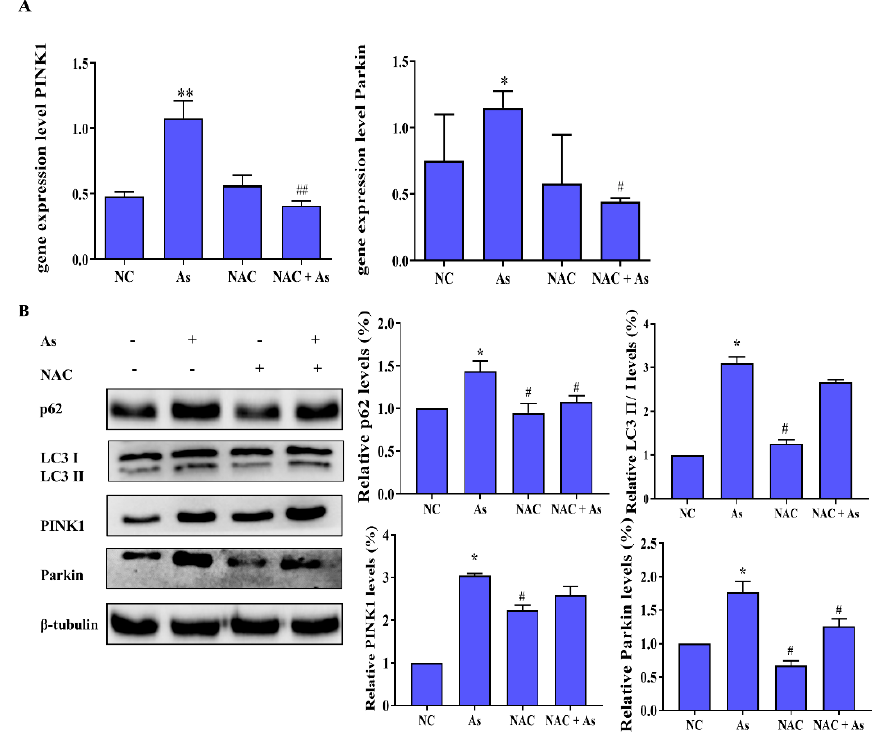
Figure 4. Effects of ROS clearance on mitophagy-related genes and proteins in PINK1/Prkin pathway. ( A ) RT-qPCR was used to detect the changes of PINK1 and Parkin mRNA in mitophagy induced by NaAsO2 treated with NAC. ( B ) Western blotting was used to detect the expression of mitophagy-related proteins induced by NaAsO2 after NAC pretreatment. * p < 0.05, ** p < 0.01 compared with the control group. # p < 0.05, ## p < 0.01 compared with the As group.